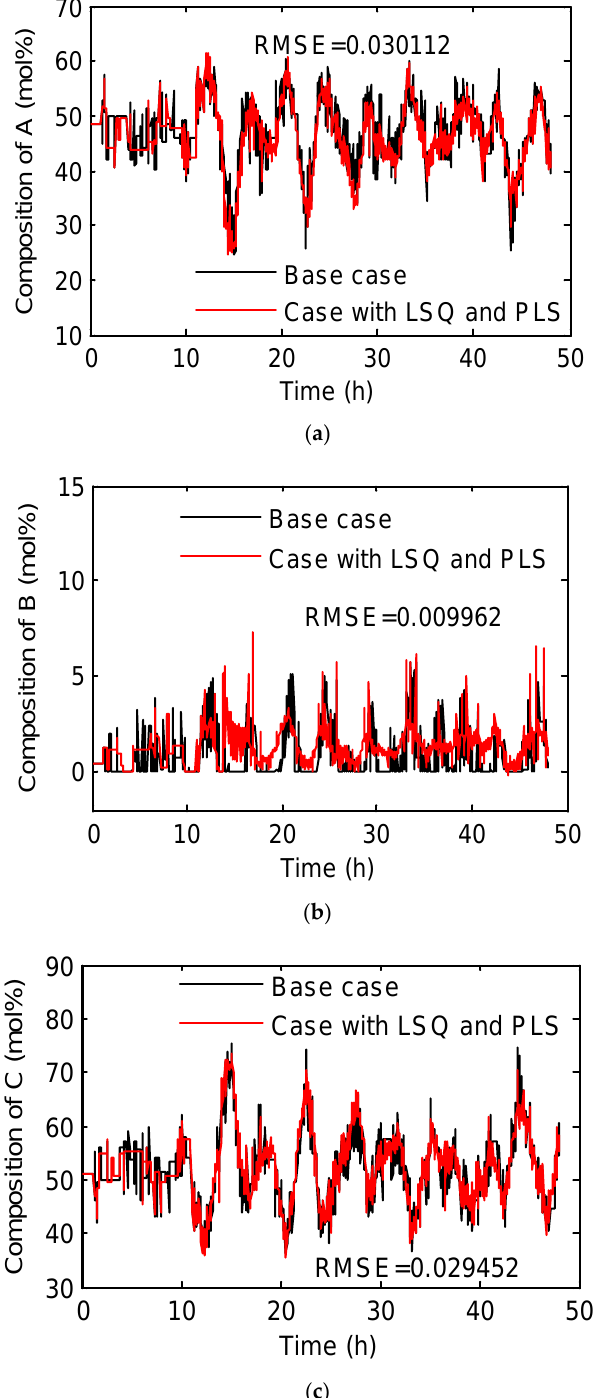
Figure 18. Fault diagnosis with a hybrid scheme under fault 8 for the ( a ) composition of A; ( b ) composition of B; ( c ) composition of C.